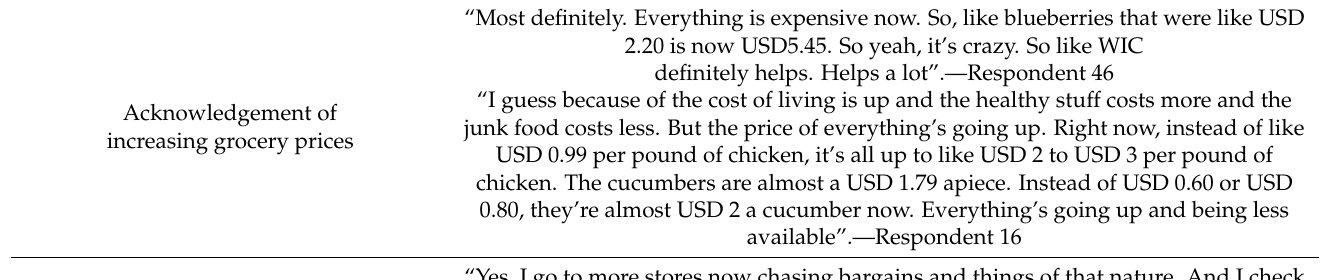
Table 3. Cont. Theme #5: Altered Shopping Practices to Account for